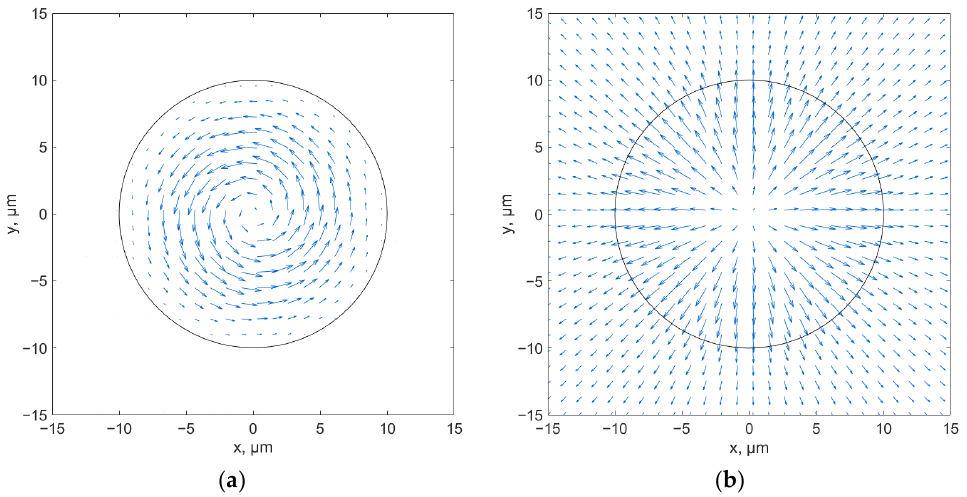
Figure 2. Spin ( a ) and orbital ( b ) parts of the transverse component of the Poynting vector of the fundamental core mode of a dielectric pipe in the case of circular polarization. The refractive index of the pipe core is 1.45 and the refractive index of the surrounding medium is 1.5. The pipe core diameter is 20 µm and the wavelength is 1 µm.